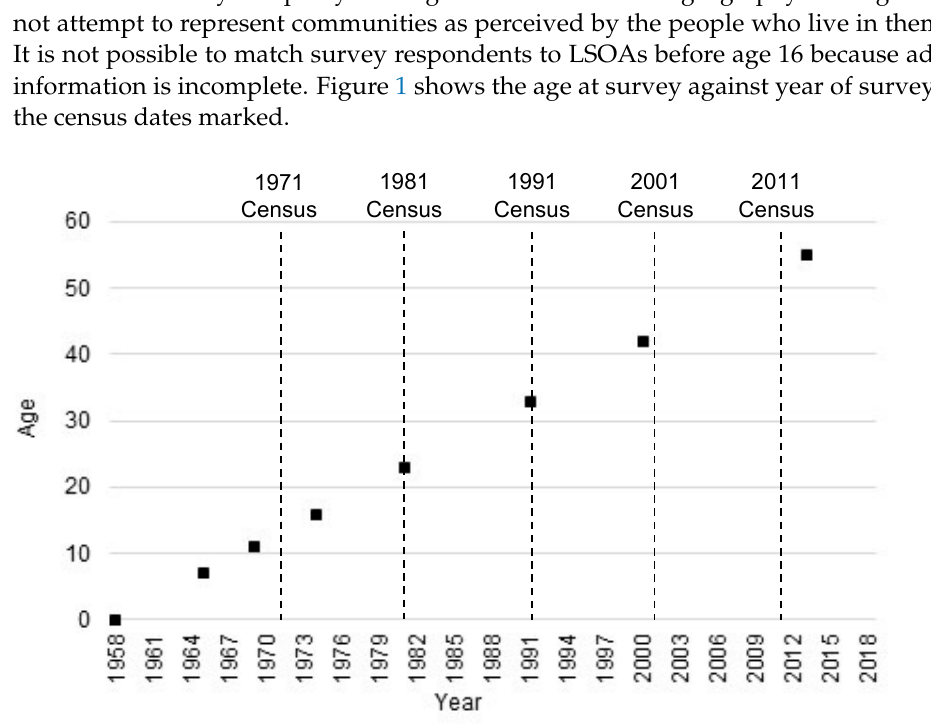
Figure 1. 1958 National Child Development Study age and year plan.